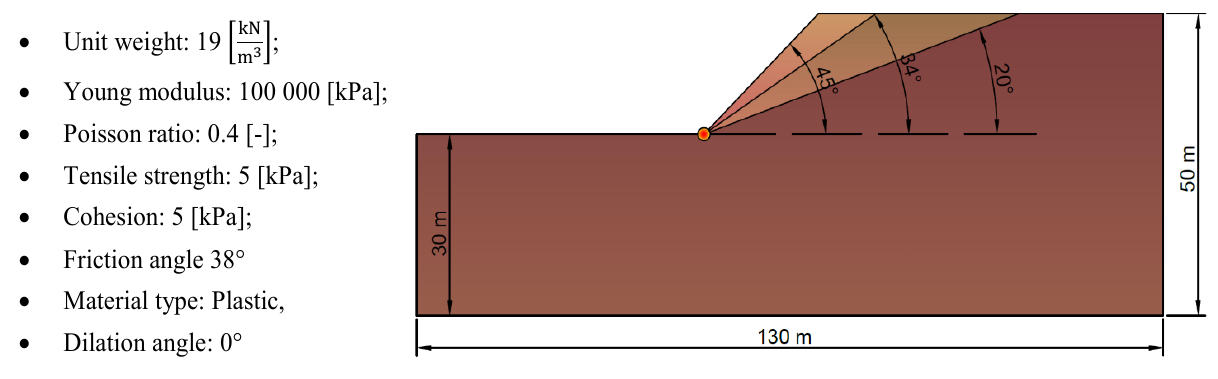
Figure 4: Geometry of slope used for numerical simulation.